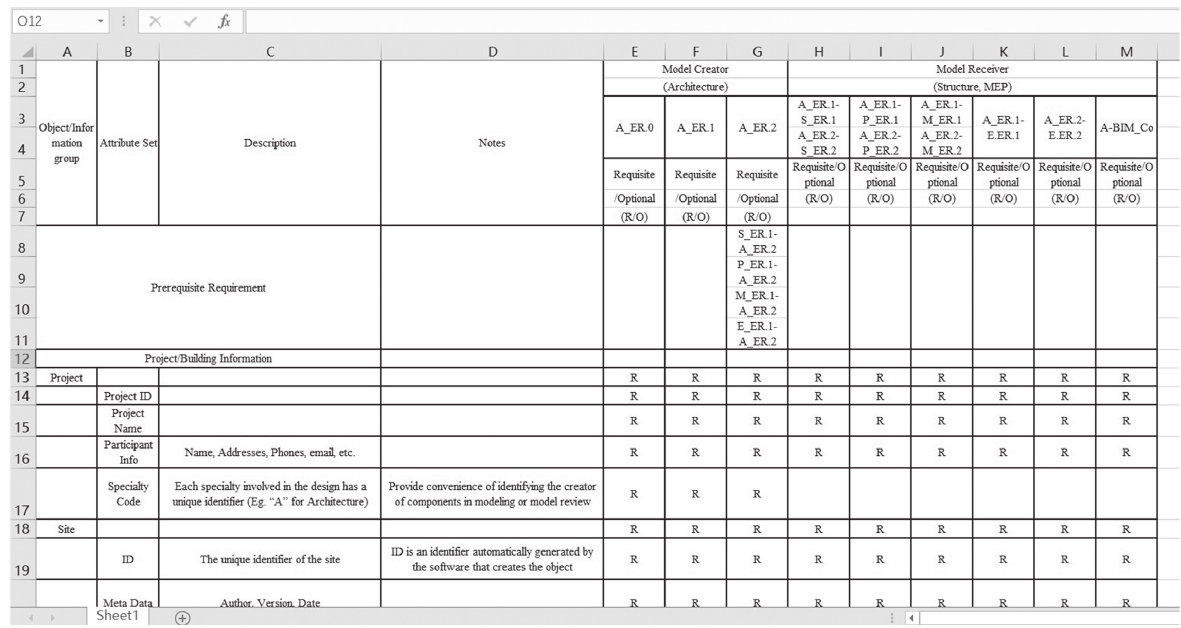
Figure 19: Exchange requirement for architecture of the sample